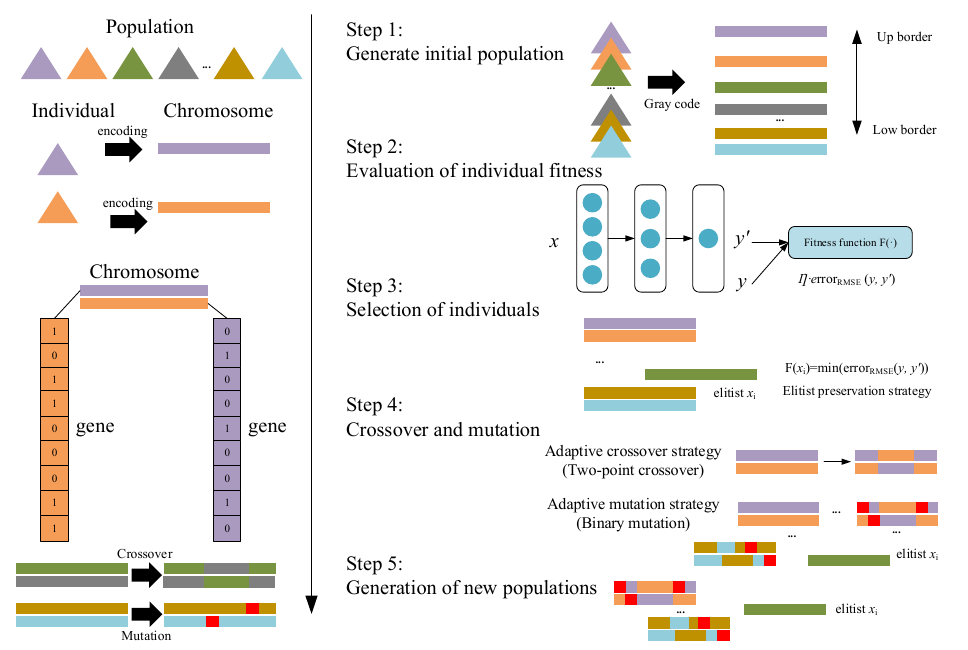
Figure 2. The schematic diagram of improved GA